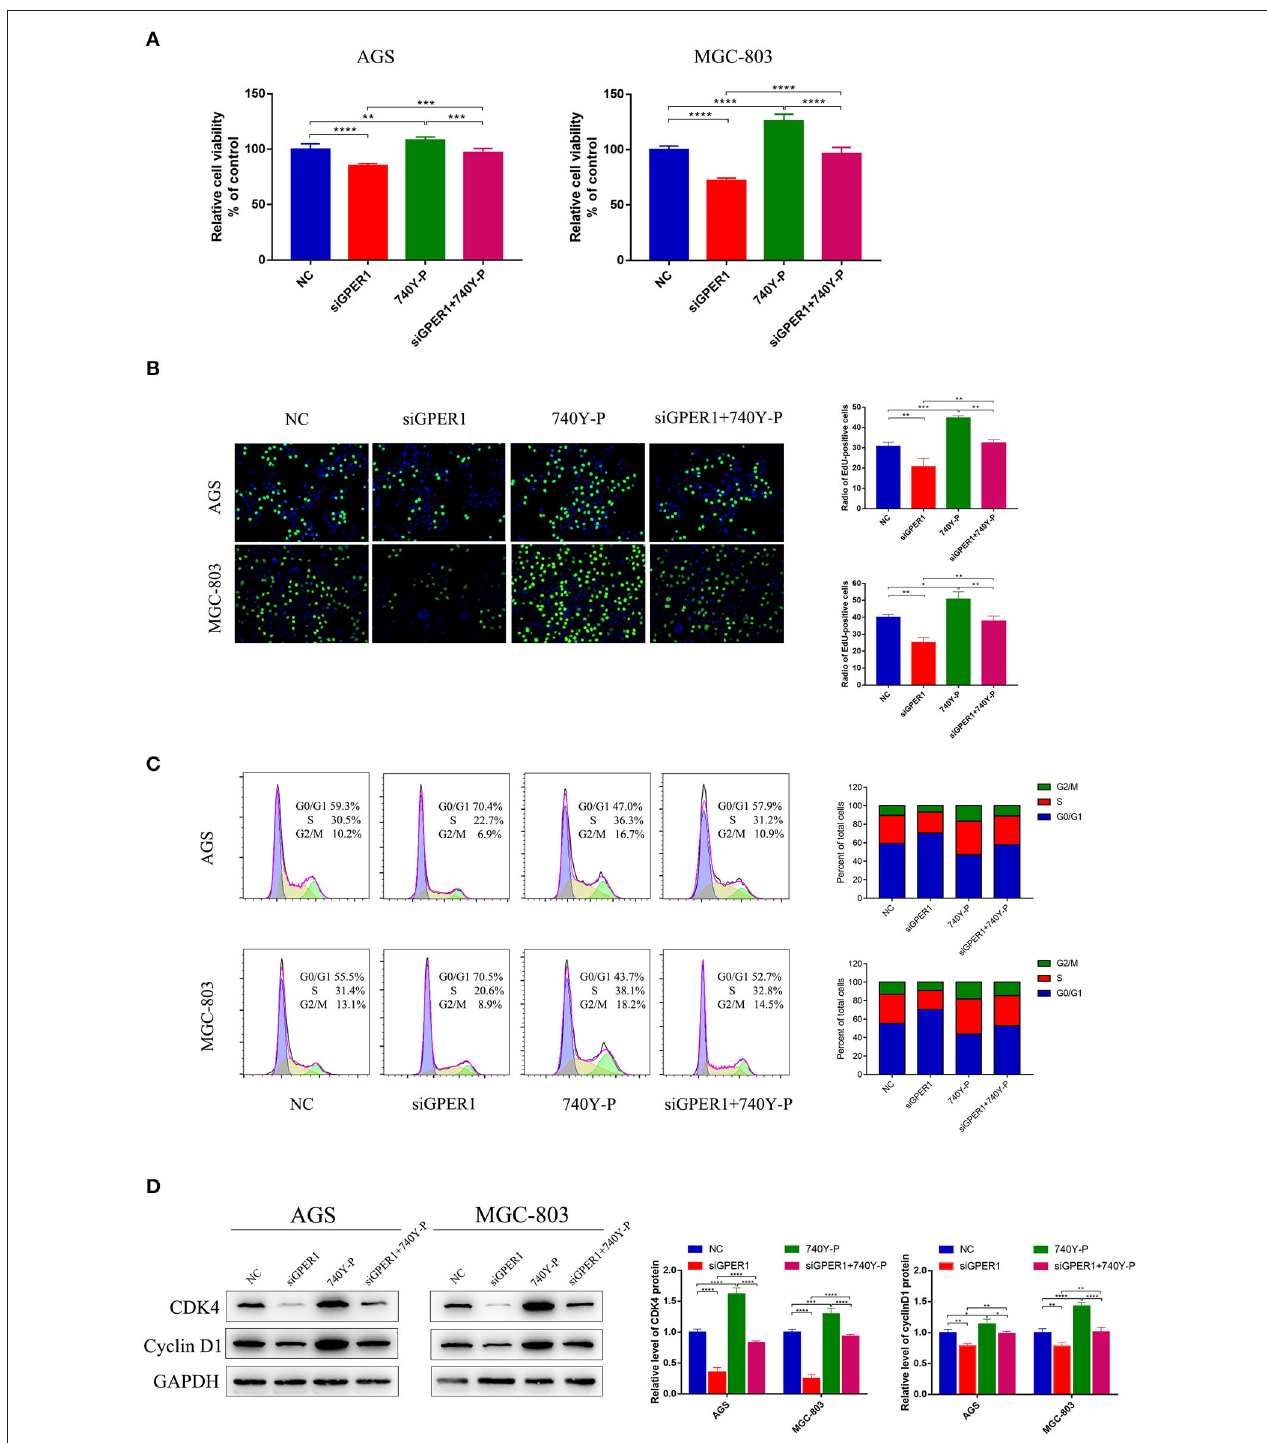
FIGURE 3 | GPER1 knockdown impairs the proliferation of AGS and MGC-803 cells. (A) CCK-8 and (B) Edu assays were used to evaluate the proliferation of AGS and MGC-803 cells after transfection with siGPER1 for 48h; (C) Flow cytometry and (D) CDK4 and cyclin D1 protein levels were used to analyze the cell cycle of AGS and MGC-803 cells after transfection with siGPER1 for 48h. Control: cells without transfection; GPER1, cells transfected with GPER1 siRNA; 740Y-P, cells treated with 740Y-P; GPER1 + 740Y-P, cells transfected GPER1 siRNA and then treated with 740Y-P. Results were shown as mean ± SD of three independent experiments, each experiment was performed in triplicate. * P < 0.05; ** P < 0.01; *** P < 0.001; **** P < 0.0001.